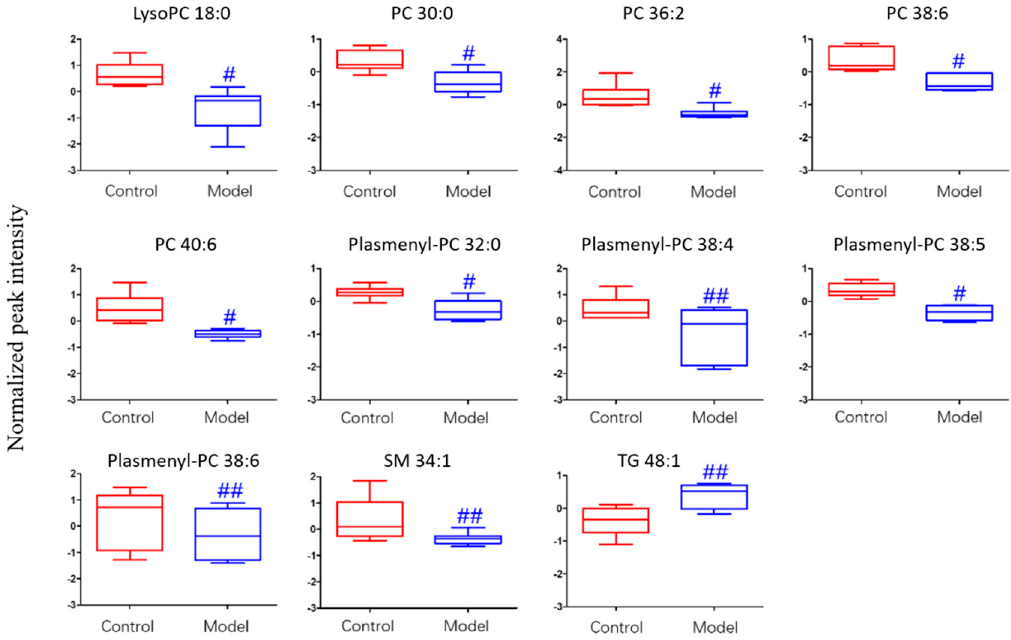
Figure 5. Box-whisker Plot of normalized peak intensity of differential lipids in BALF (positive ion mode) # p < 0.05, ## p < 0.01 vs. blank control mice.